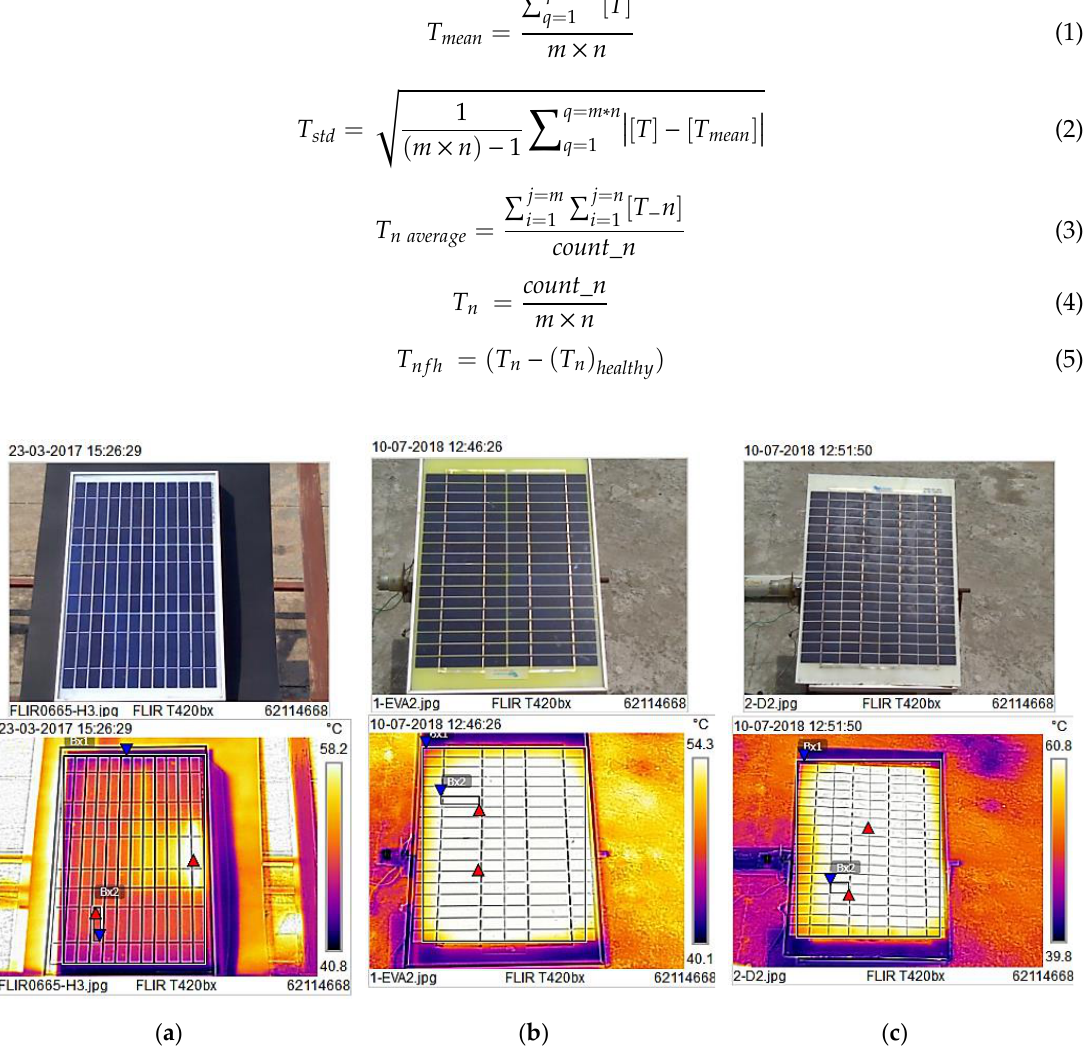
Figure 3. Photograph and thermal image of the Photovoltaic (PV) panel: ( a ) healthy, ( b ) Ethylene Vinyl Acetate (EVA) discolouring defect, ( c ) delamination defect. Table 4. Mean and std of the temperature matrix of the PV panel and